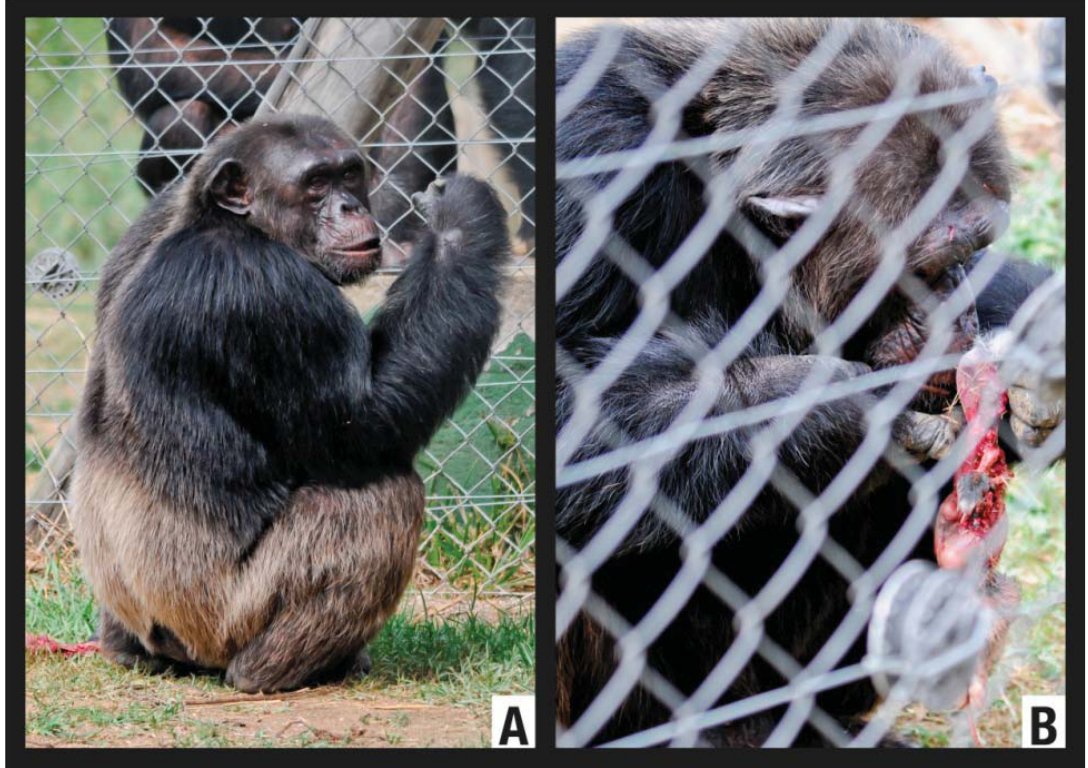
Figure 5. Predation of an Oryctolagus cuniculus (Episode H4) by